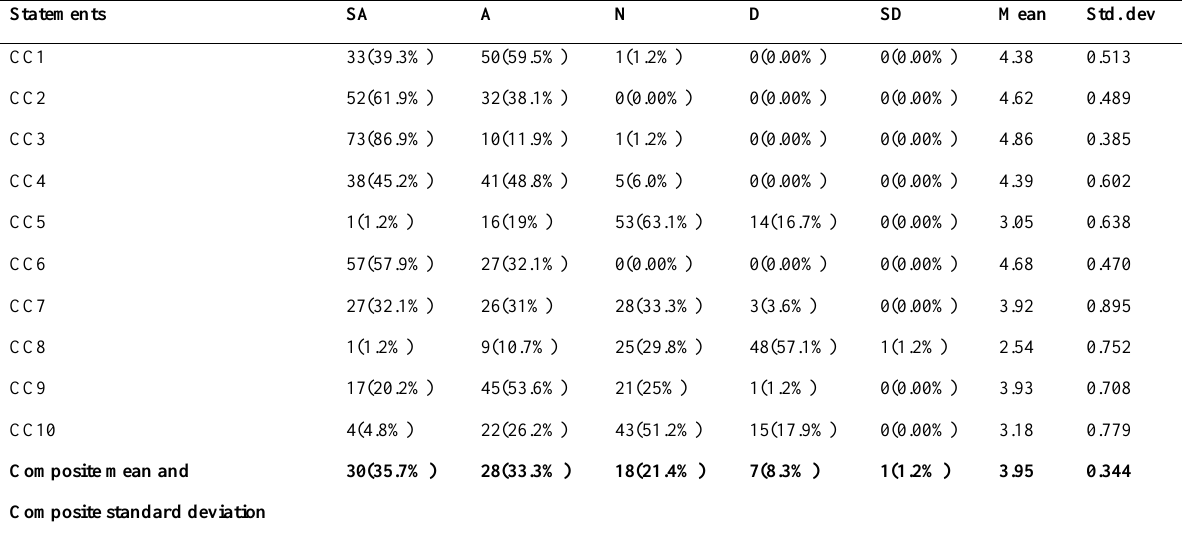
Table 1: Contingent Capital and Performance of Hydroelectric Energy